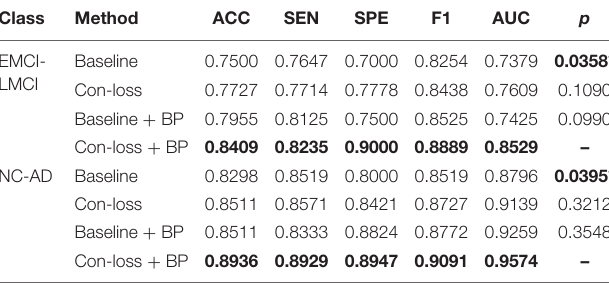
TABLE 6 | Results of the main studies based on the Schaefer et al. (2018) atlas.